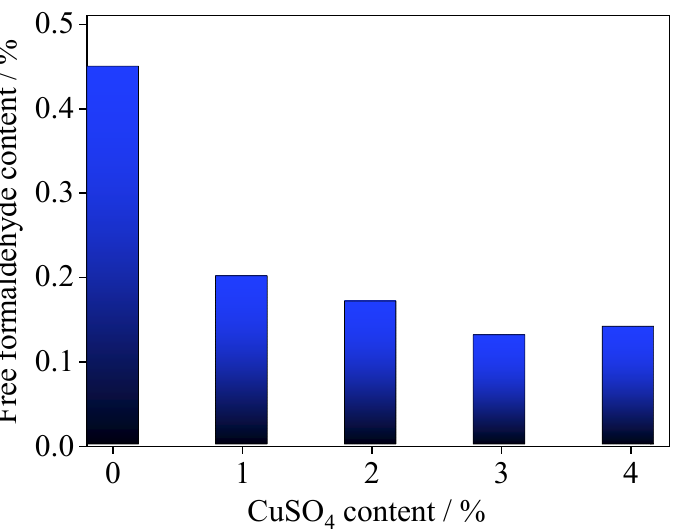
Figure 1. Relationship between copper (II) sulfate content in UF resin adhesive and the free formaldehyde content.